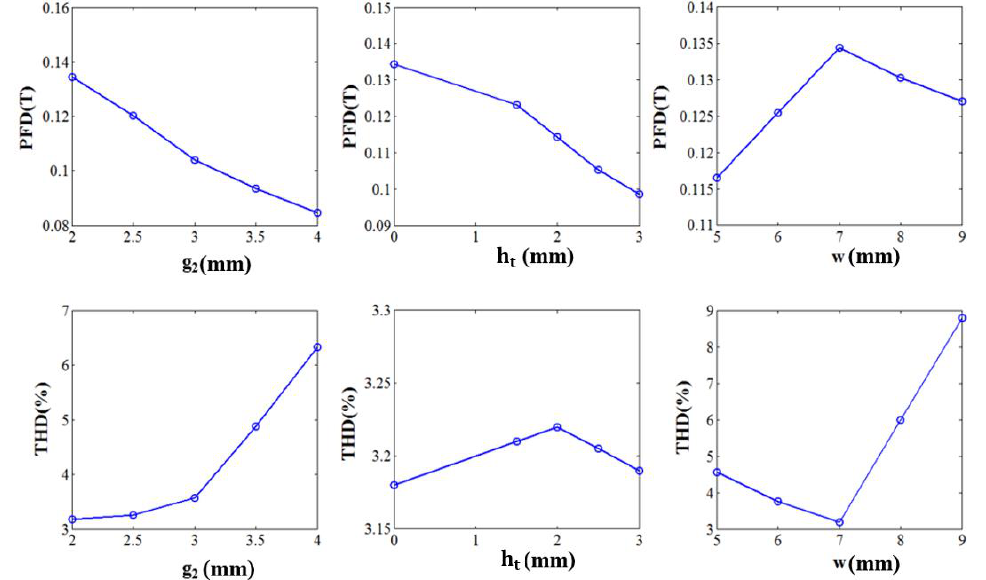
Figure 9. PFD and THD variation with the variation of g 2 , h t , and w.